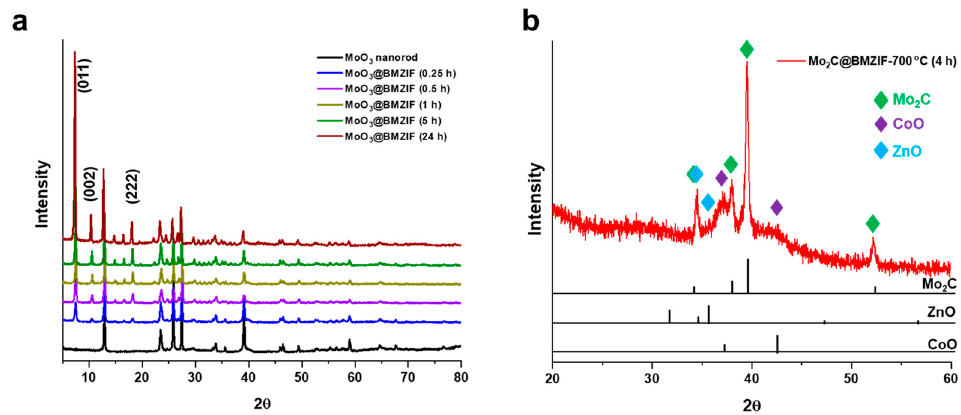
Figure 2. XRD patterns of ( a ) as-prepared MoO 3 nanorods and MoO 3 @BMZIF catalysts obtained at different reaction times (0.25–24 h), and ( b ) Mo 2 C@BMZIF-700 °C (4 h).